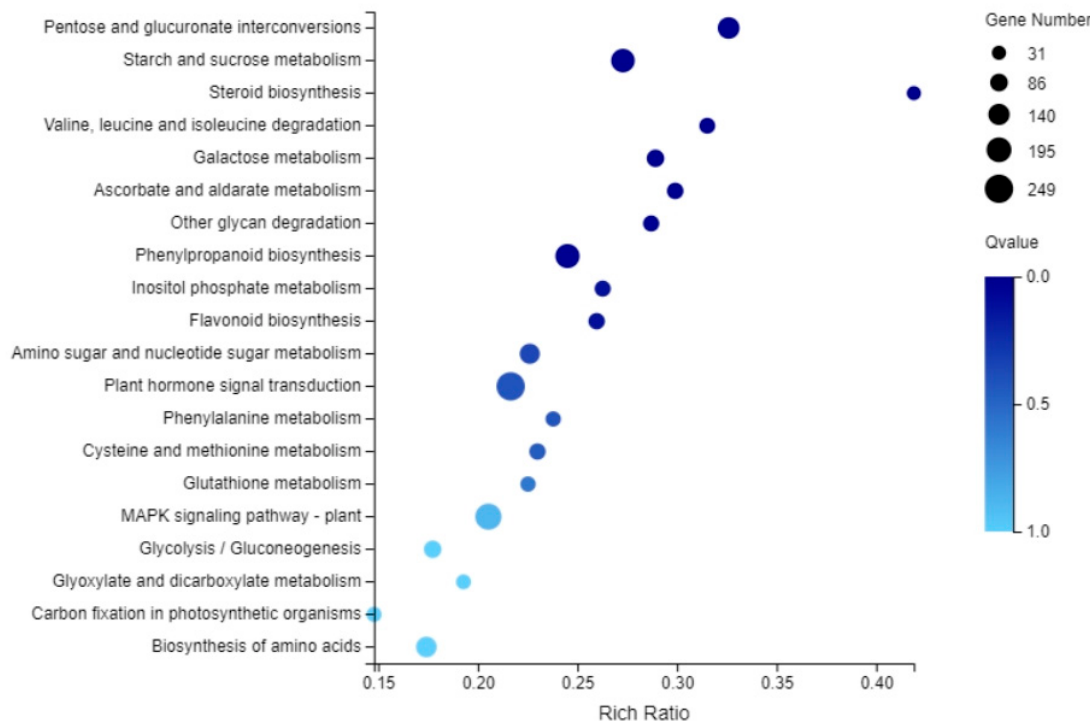
Figure 4. Bubble diagram of KEGG pathway enrichment of differentially expressed genes. Note: Rich Radio: enrichment ratio, the larger the bubble, the greater the number of genes.